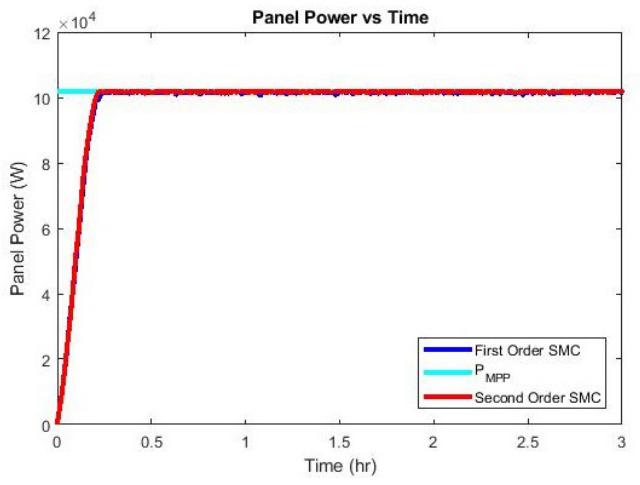
Figure 14. PV array output power at 1000 W/m 2 .